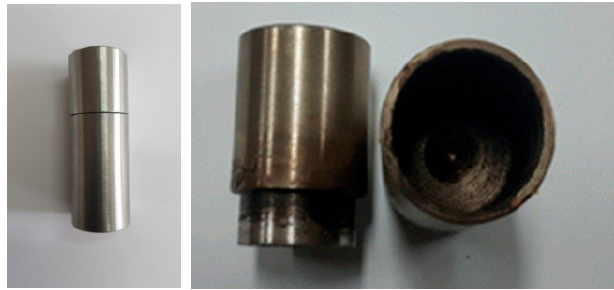
Figure 2. Prototype capsule.